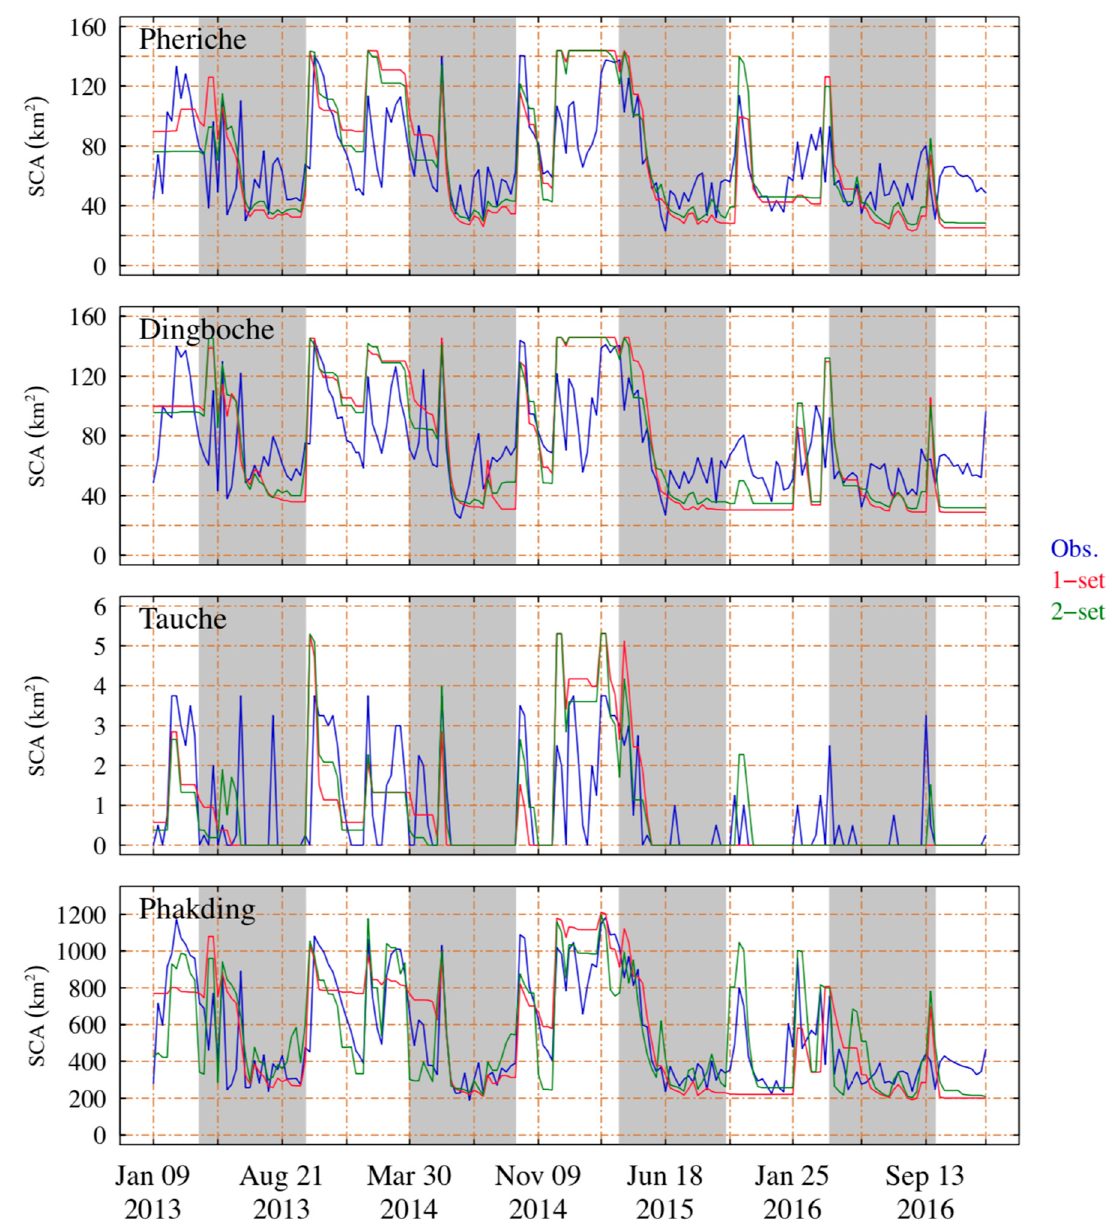
Figure 10. Evolution of simulated SCA, with the “one-set” (red line) and the “two-set” (green line) version of the snowmelt model, along with the 8-day SCA provided by MOD10A2 (blue line), on average per basin, for the five basins during the 2013–2016 period. The summer seasons are highlighted in gray.